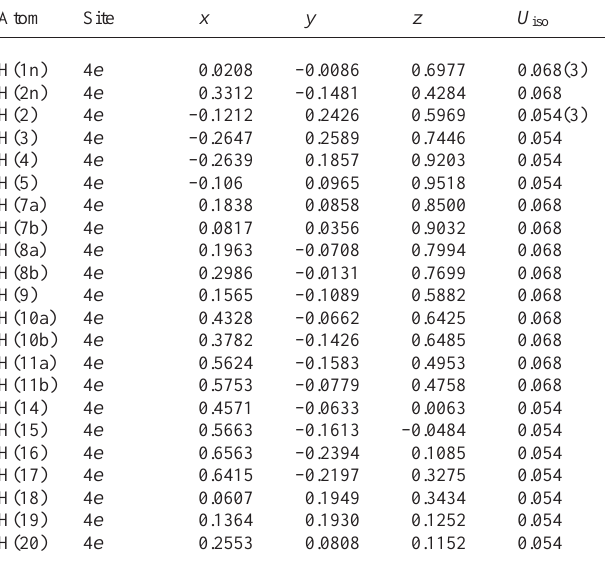
Table 2. Atomic coordinates and displacement parameters (in Å 2 )